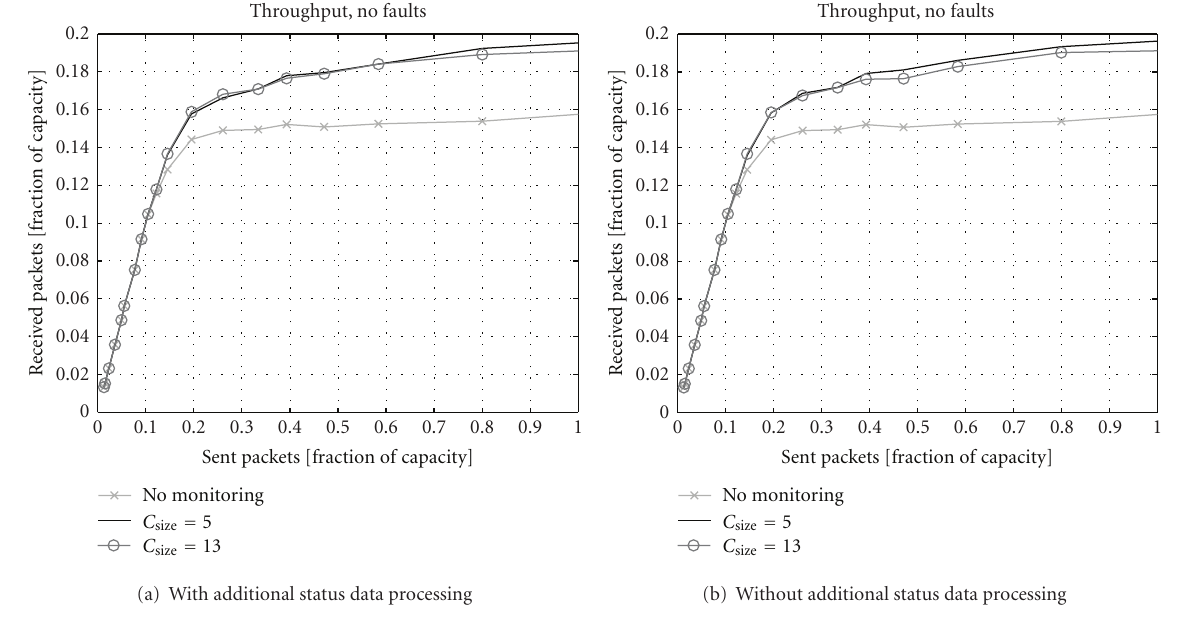
Figure 7: Throughput with di ff erent sized clusters ( C size ) without network faults.